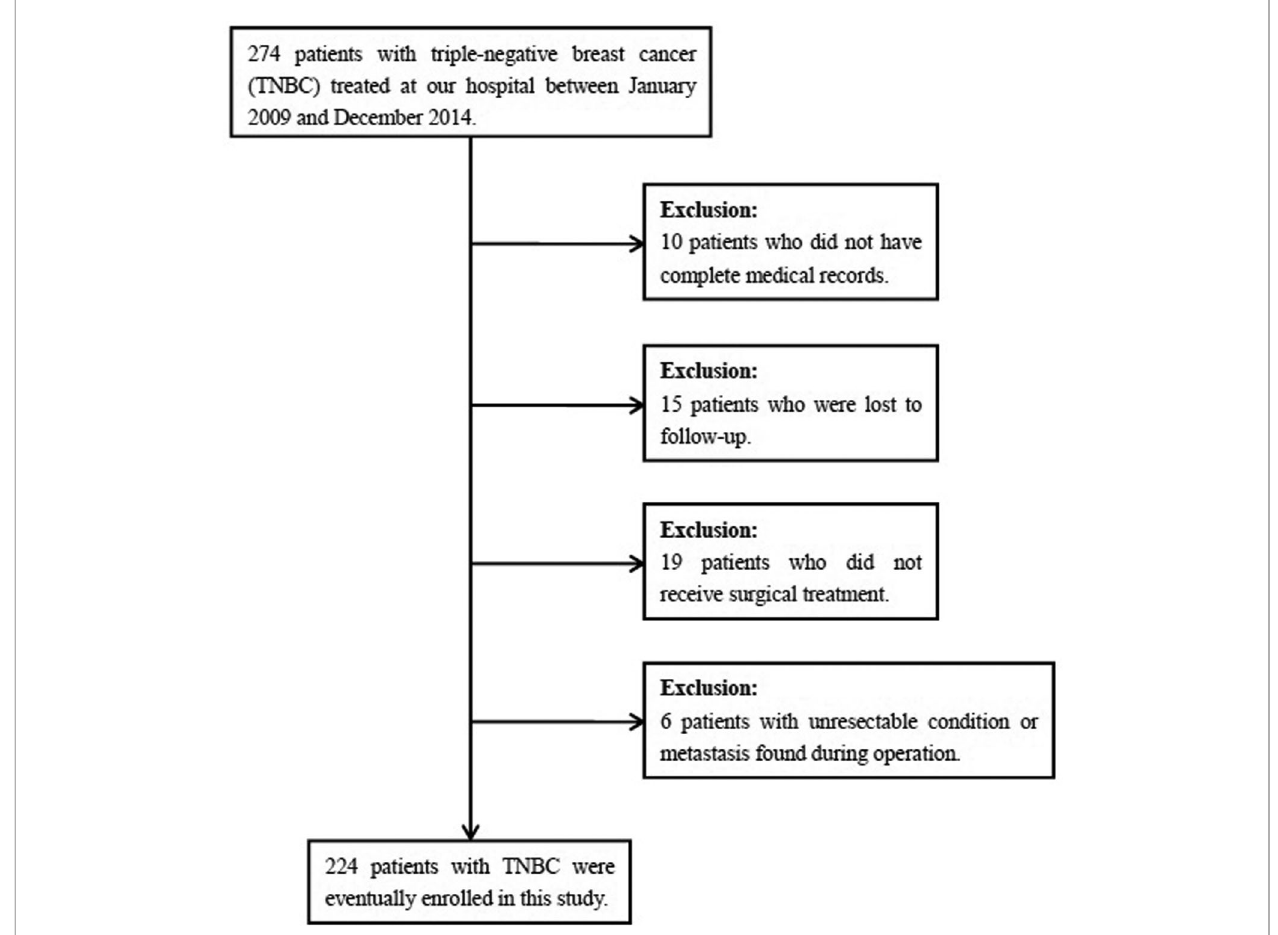
FIGURE 1 | Flow diagram of the process of selection of the patients included in this